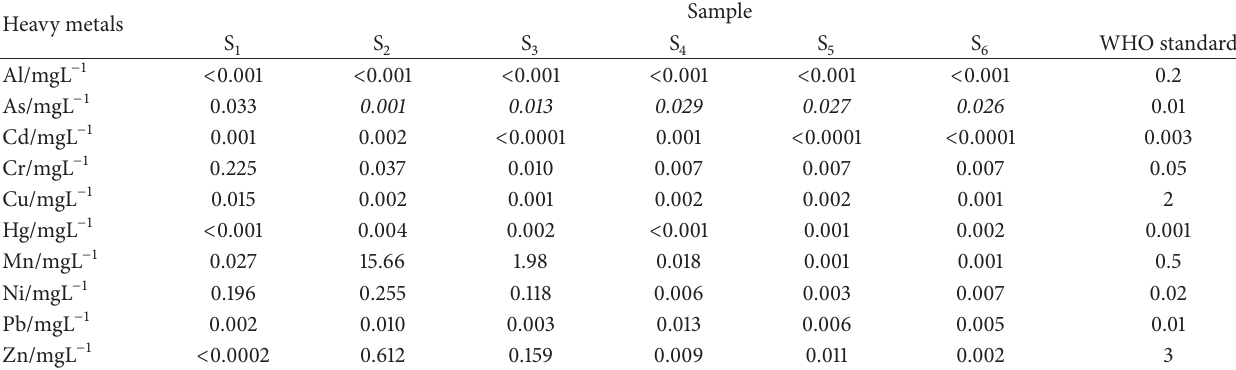
Table 3: Concentration of 10 metals determined in river water.